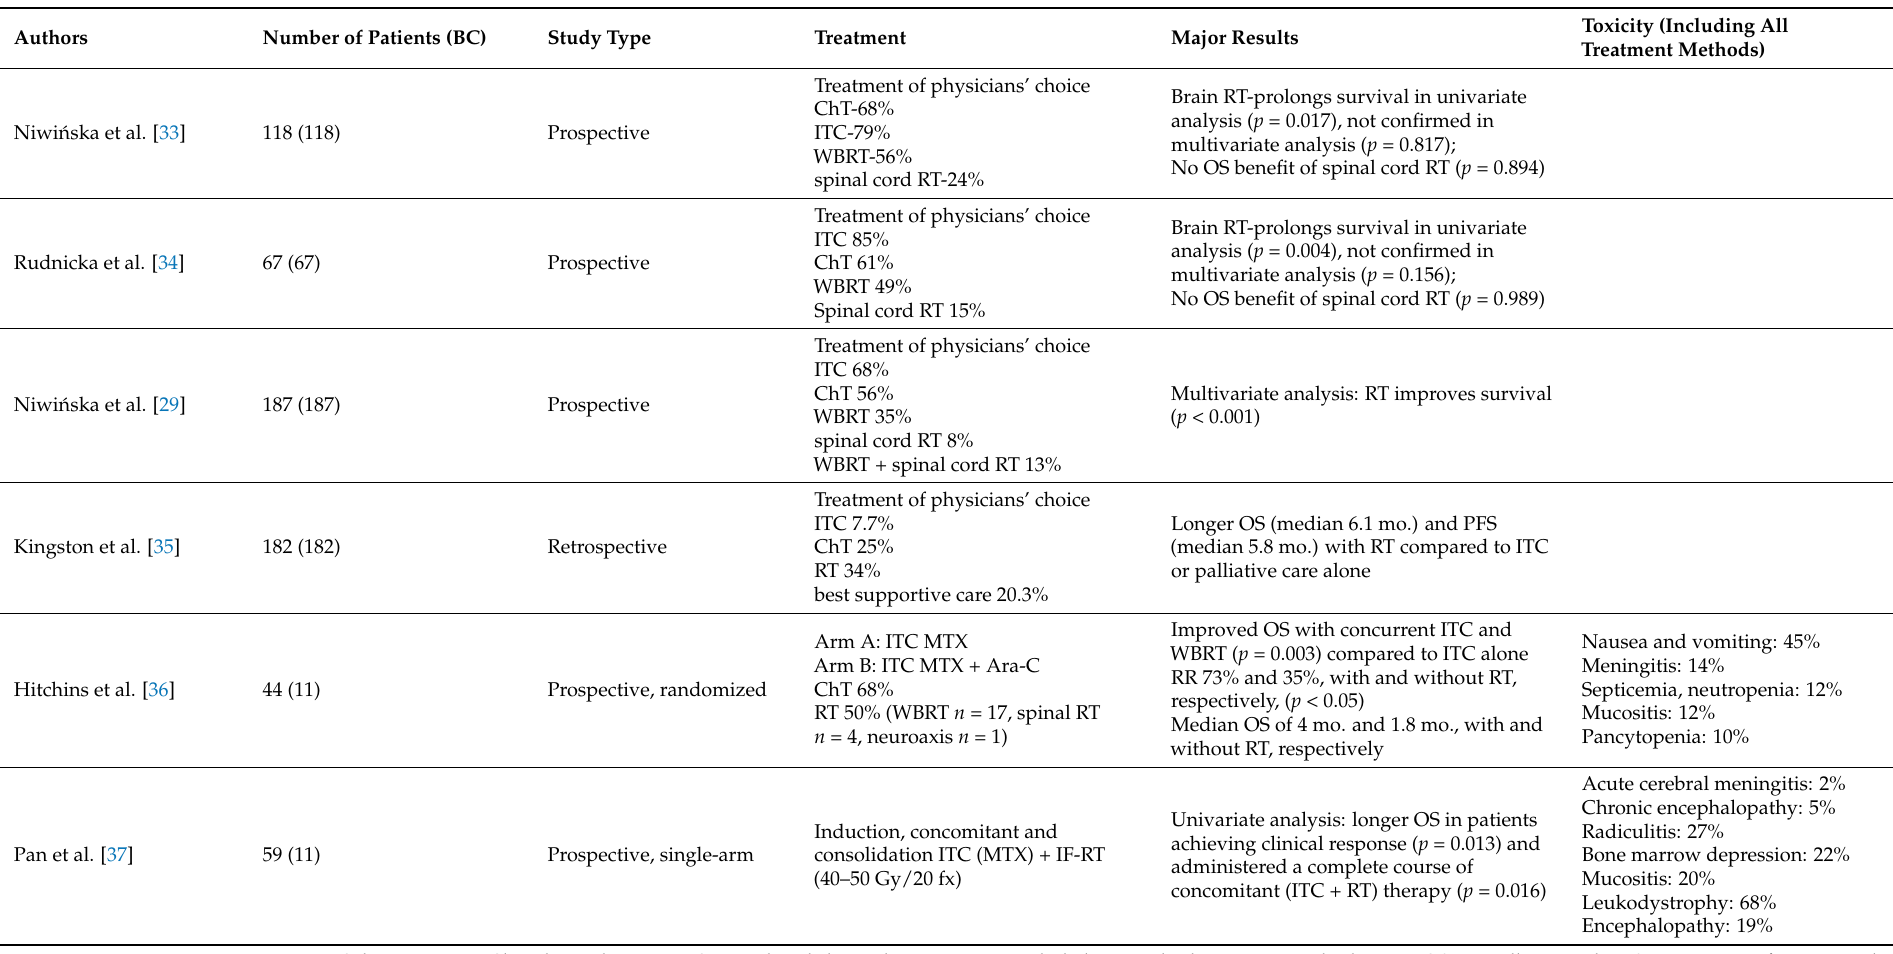
Table 1. Clinical studies evaluating the survival impact of radiotherapy for leptomeningeal carcinomatosis in breast